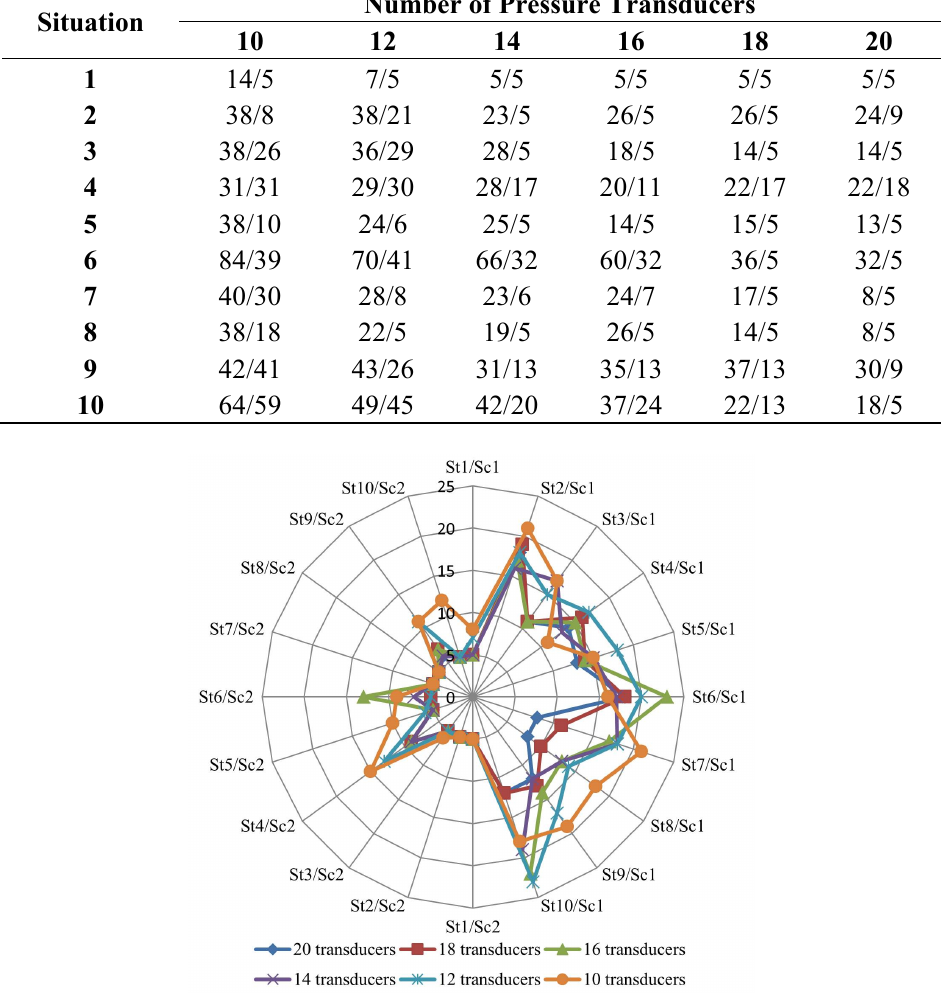
Figure 7. Number of reliable leaky pipes in the second WDN.